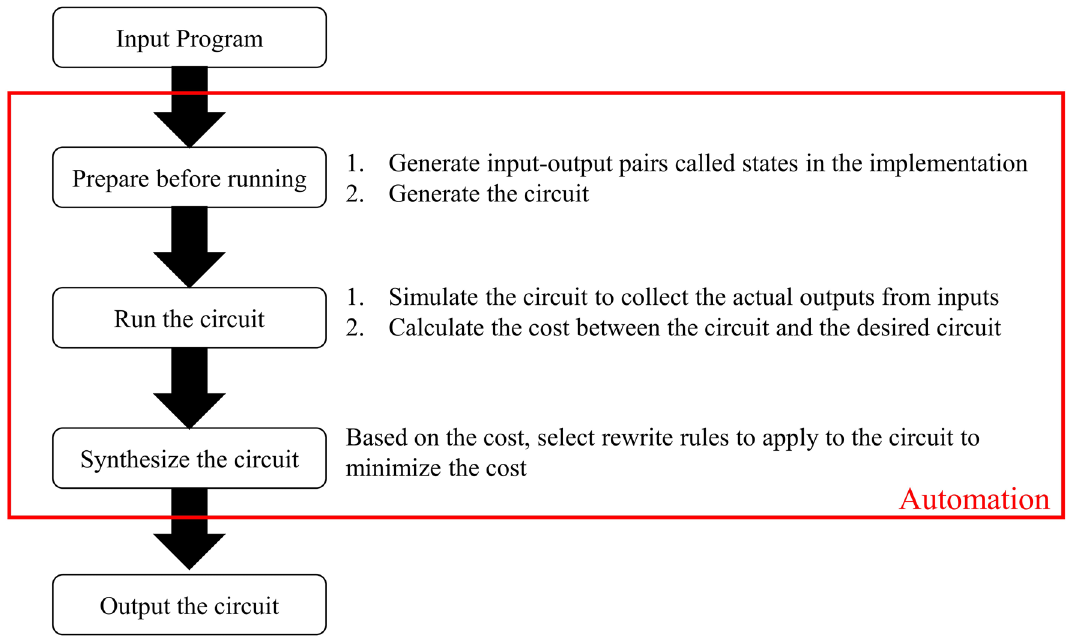
Figure 7. High-level workflow of the framework. The input to the framework is a program written in conventional high-level languages such as C or C++ . Next, the framework prepares input–output pairs to represent this program and randomly generate a circuit. Then, the circuit is simulated to collect actual outputs from inputs and calculate the cost. Finally, based on the cost, rewrite rules are selected, and the acceptance probability is calculated to find the correct circuit implementation as the output of the